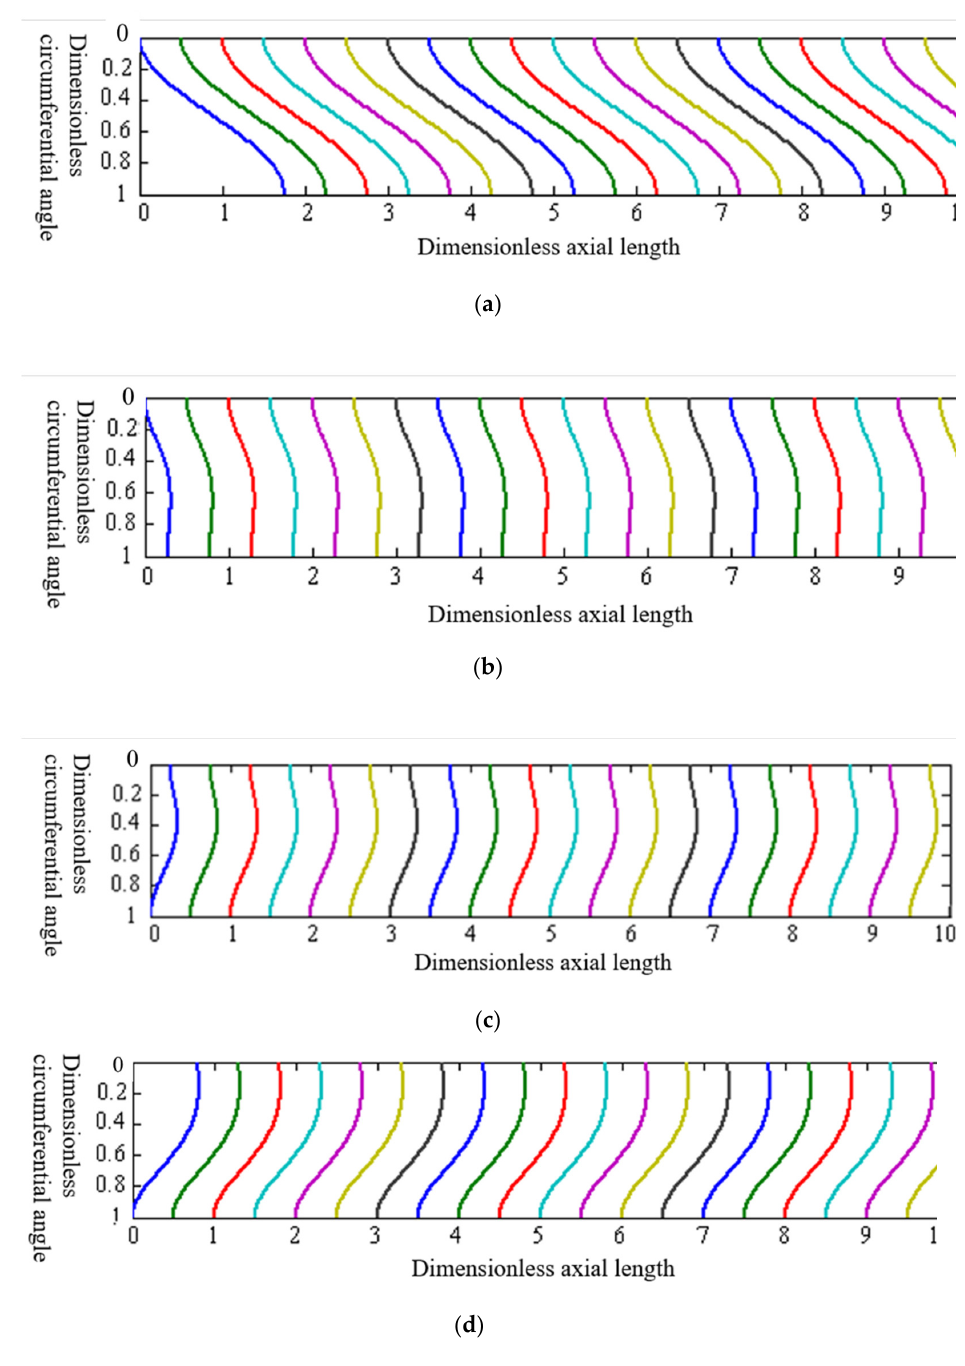
Figure 7. The influence of casing eccentricity on displacement interface. ( a ) casing eccentricity = 0; ( b ) casing eccentricity = 0.3; ( c ) casing eccentricity = 0.4; ( d ) casing eccentricity = 0.5.